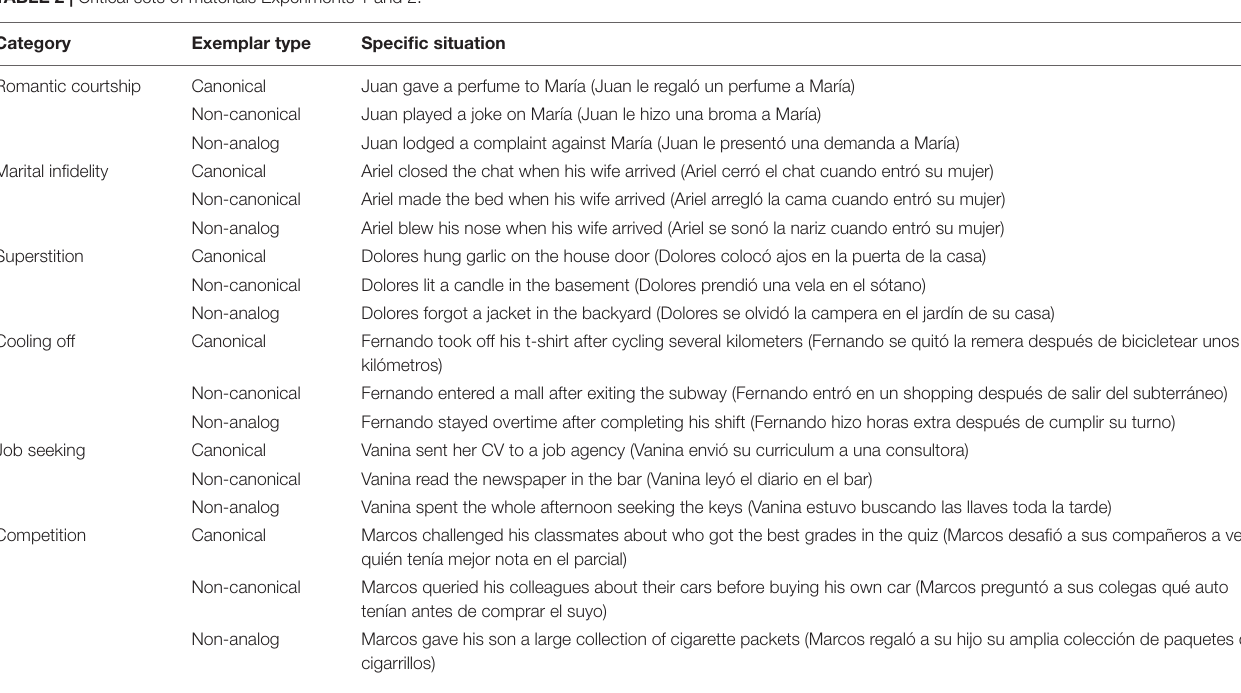
TABLE 2 | Critical sets of materials Experiments 1 and